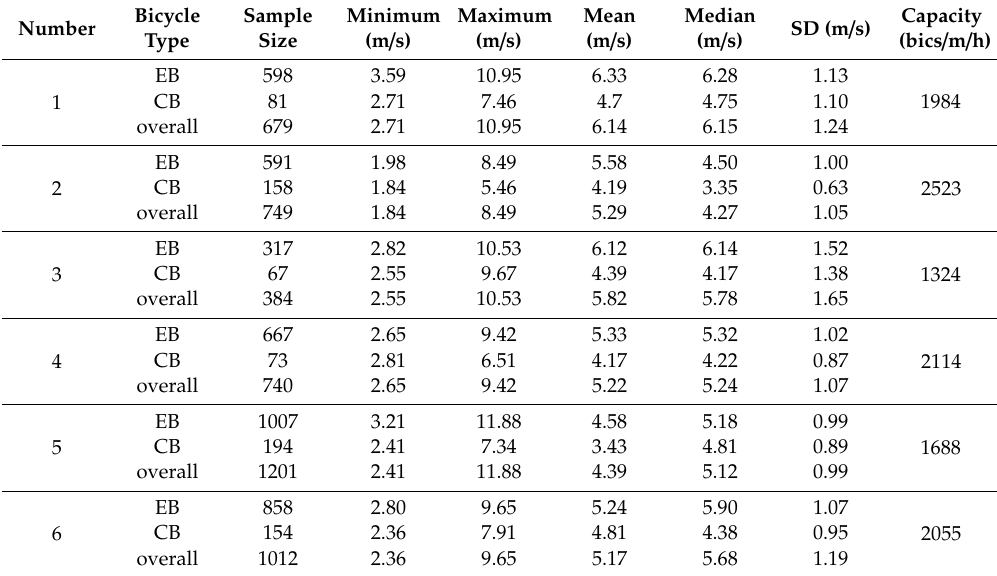
Table 2. Bicycle speeds and track capacities at six bus